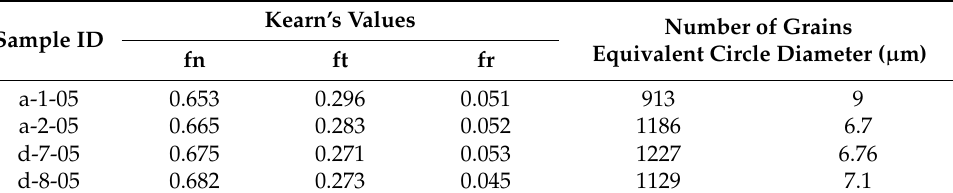
Table 4. Test Matrix for EBSD Texture Analysis.